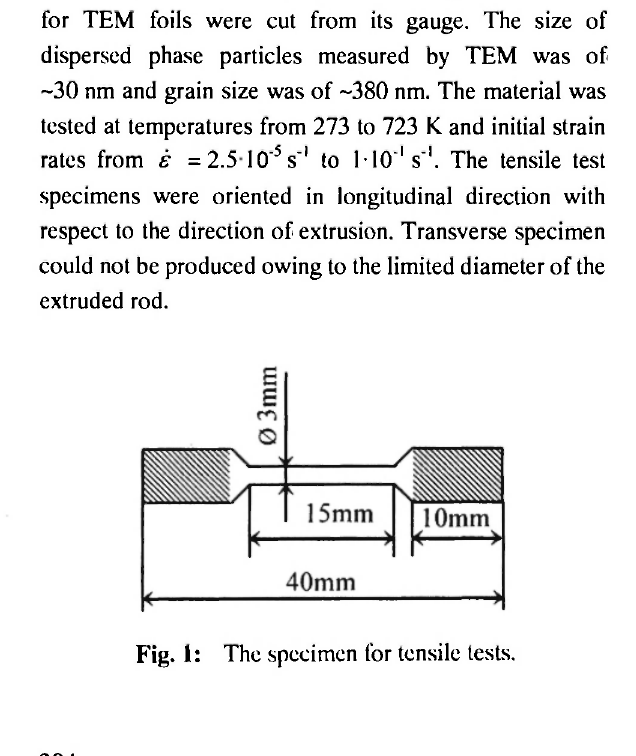
and the reduction of area Ζ in Figs. 3,4 for different A1 4 C